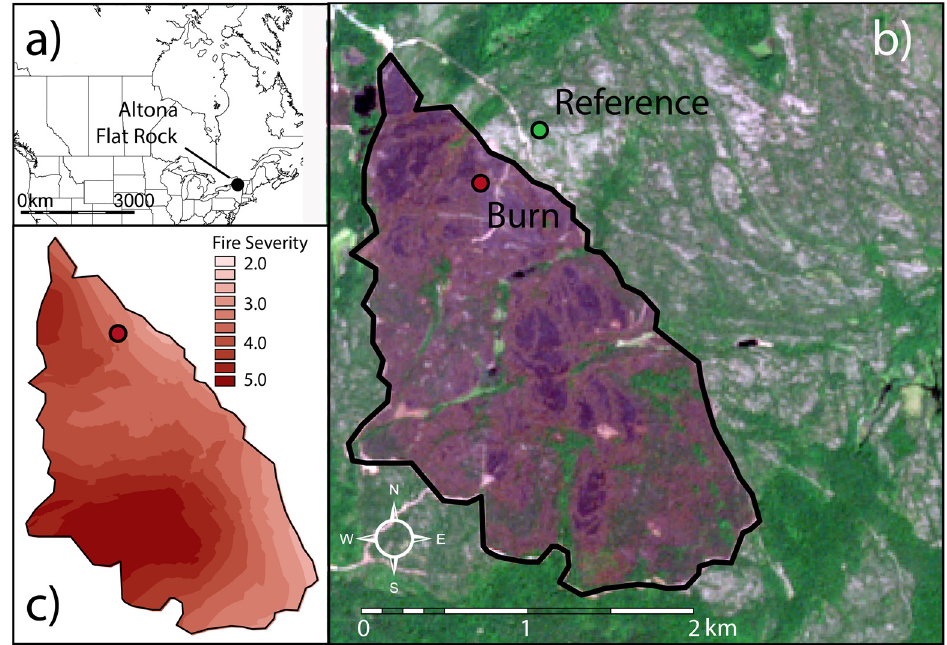
Figure 1. Study site map illustrating ( a ) geographic region, ( b ) map of 2018 wildfire extent with reference and burn sites indicated, and ( c ) fire severity gradient with burn site indicated.